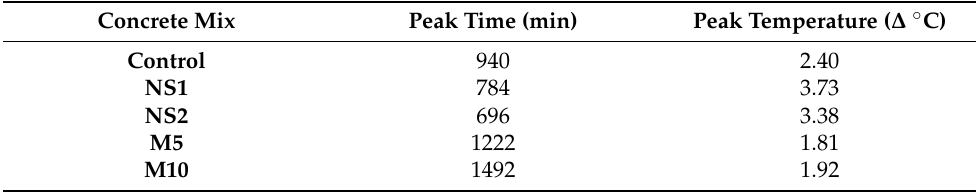
Table 2. Isothermal details of the UWC specimens with NS and